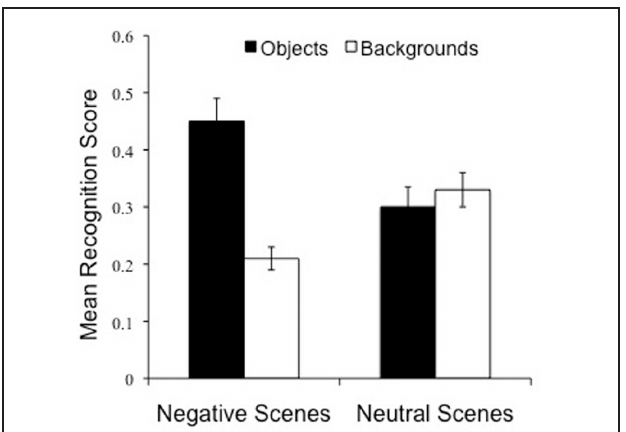
FIGURE 4 | Twenty-four hours delay memory performance overall. The emotional memory trade-off effect is preserved following a 24h delay. Note that object memory is superior for negative, compared to neutral, scenes ( p < 0 . 001), while scene backgrounds are more poorly remembered if they are paired with negative, compared to neutral, objects ( p < 0 .